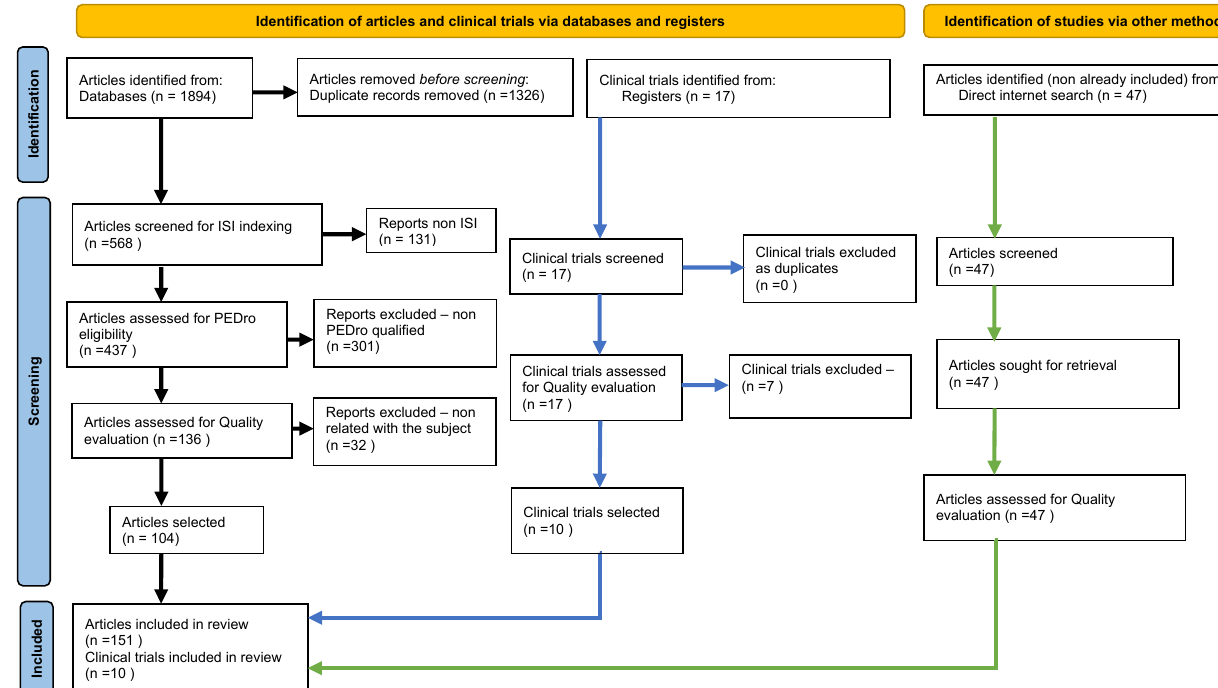
Figure 1. Our adapted PRISMA-type flow diagram.